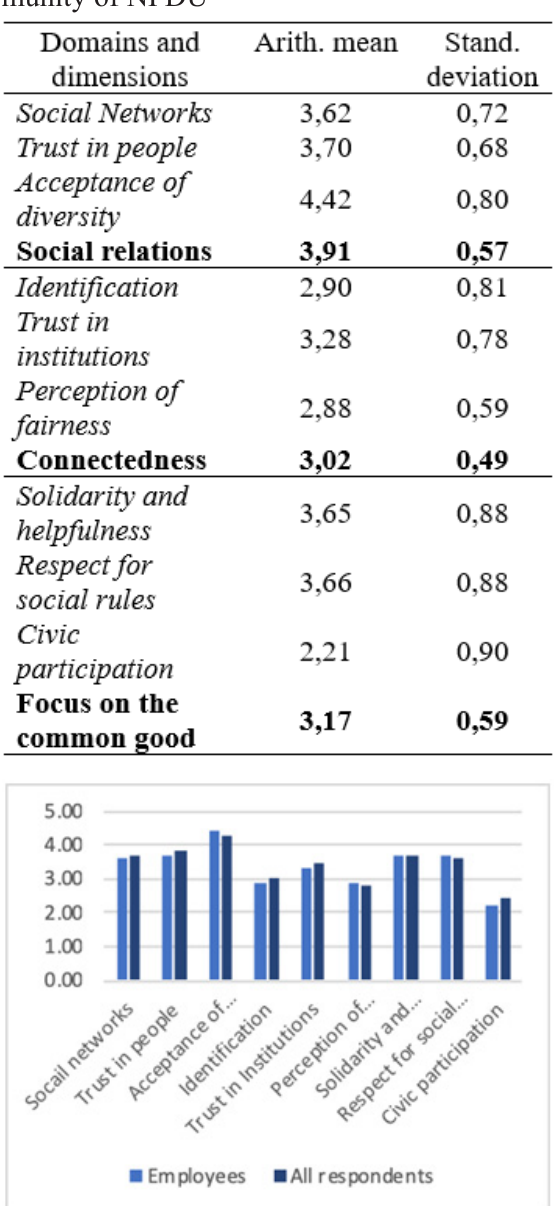
Table 3. Results of the evaluation of the employees’cohesion in the university com-